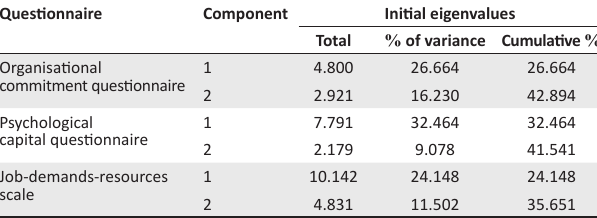
TABLE 2: Initial eigenvalues for the total variances explained.